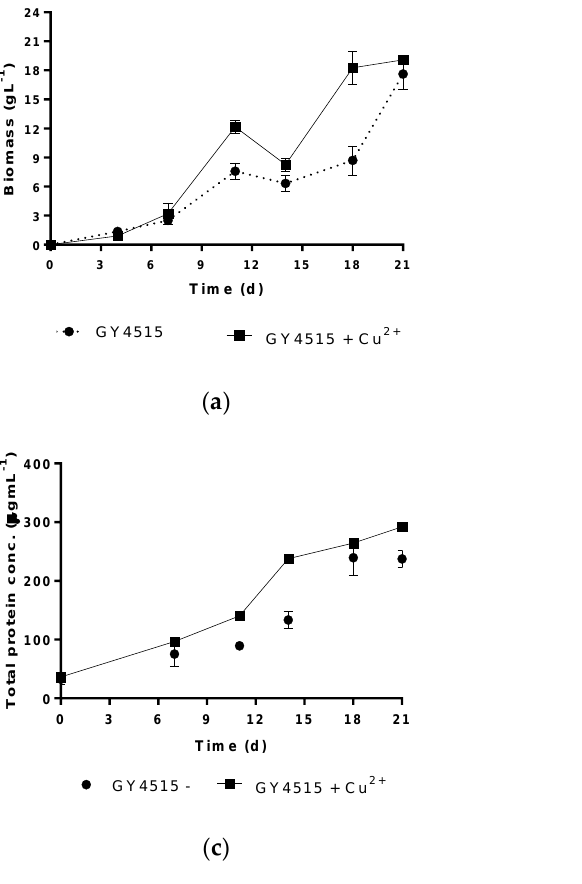
Figure 5. Growth profile of P. ostreatus in GY4515 culture media: ( a ) biomass production; ( b ) glucose consumption; ( c ) total protein in culture extract; ( d ) laccase activity (as Log 10 ). Black circle — discontinuous line (no copper sulfate); black square — continuous line (copper sulfate 1 mM).